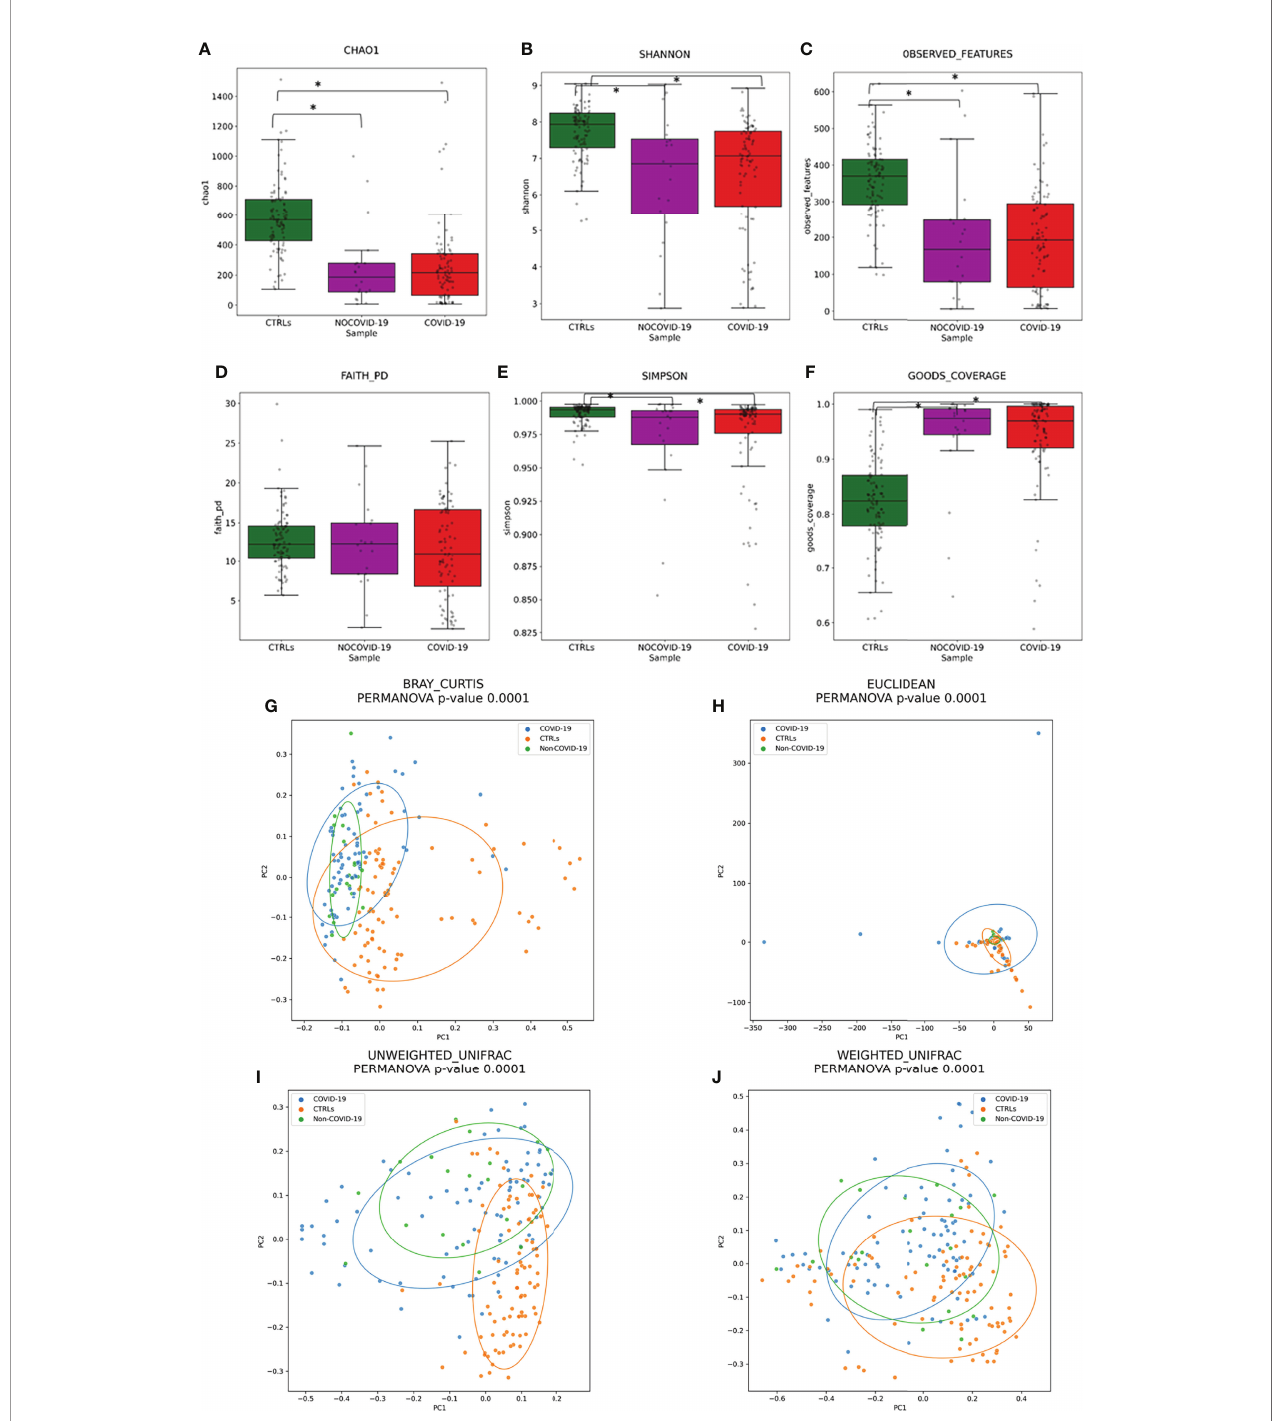
FIGURE 2 | Gut microbiota ecology evaluation. Alpha-diversity of COVID-19 and Non – COVID-19 cohorts and CTRLs based on Chao-1 (A) , Shannon (B) , observed species (C) , Faith PD (D) , Simpson (E) , and Good ’ s coverage (F) indices. Statistically signi fi cant ( p -value < 0.05) comparisons by ANOVA test are indicated by asterisk. Beta-diversity of COVID-19 and Non – COVID-19 cohorts and CTRLs, performed by Bray – Curtis (G) , Euclidean distance (H) , and unweighted (I) and weighted (J) UniFrac